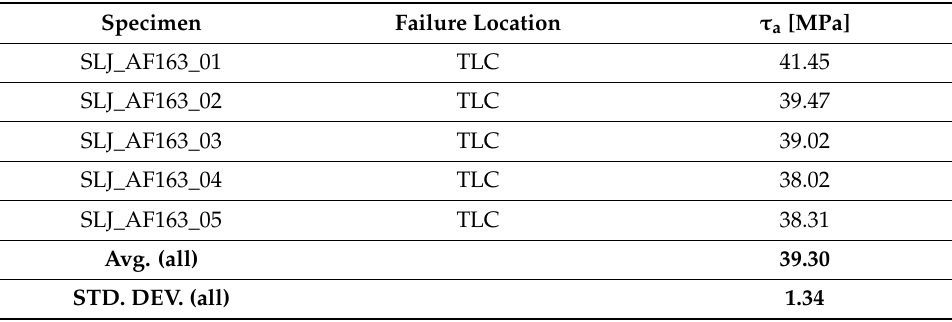
Figure 6. Force-displacement results of SLJ_AF163 tests. Table 3. Failure location and tensile strength of SLJ_AF163 tests.